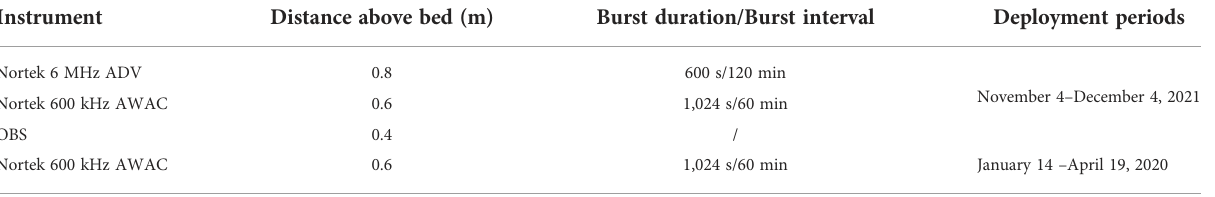
TABLE 1 Summary of instrumentation and sampling parameters at observation